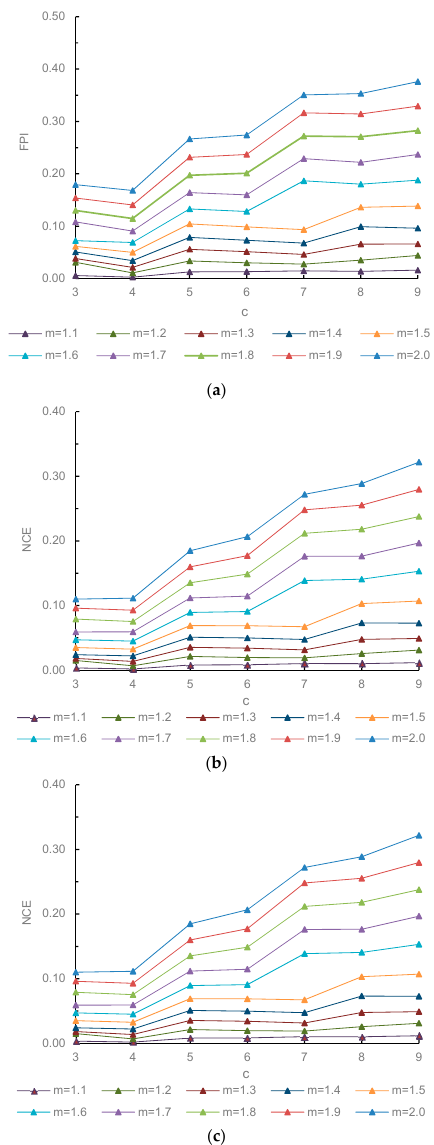
Figure 16. FPI, NCE, and derived function curves with di ff erent combinations of c-m (c is the cluster number, m is the weighting exponent). ( a ) Variation of fuzzy performance index (FPI) along m with di ff erent c. ( b ) Variation of normalized classification entropy (NCE) along m with di ff erent c. ( c ) Variation of derived function along c with di ff erent